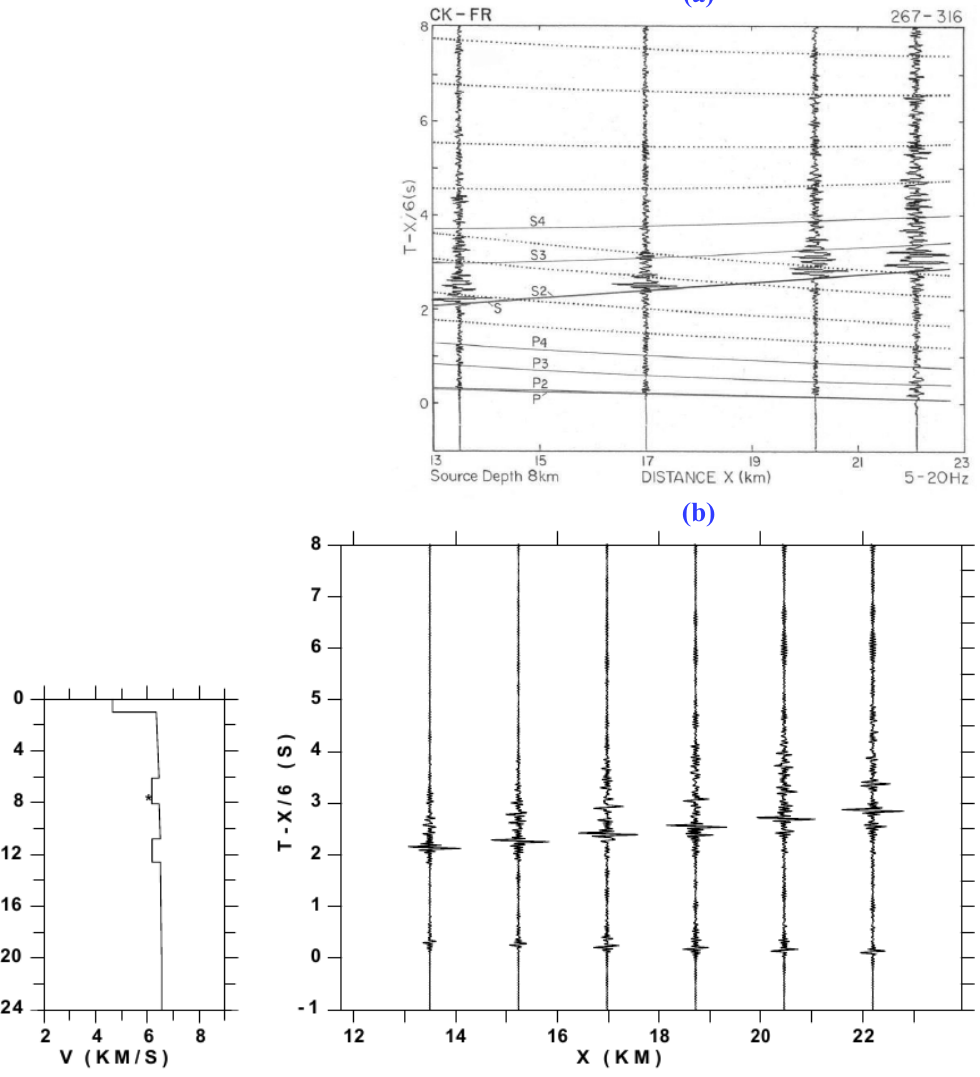
Figure 10. (a) Same as Figure 9a observed record section assembled from seismograms of local earthquakes with similar source mecha- nisms (the dominant mechanism is normal), aligned to an average source depth of 8 km, and recorded at a combination of the seismograph stations CK, and FR in the Koyna-Warna region. Note significantly lower amplitudes of various phases, particularly P reflections and P-to- S conversions, as compared to those in Figure 9a. (b) Same as Figure 9b synthetic seismogram section computed for a different set of the virtual source parameters and using the same inferred models of the upper crustal P and S velocity structure in the region. The amplitudes are trace-normalized. The left panel shows the same P velocity model as in Figure